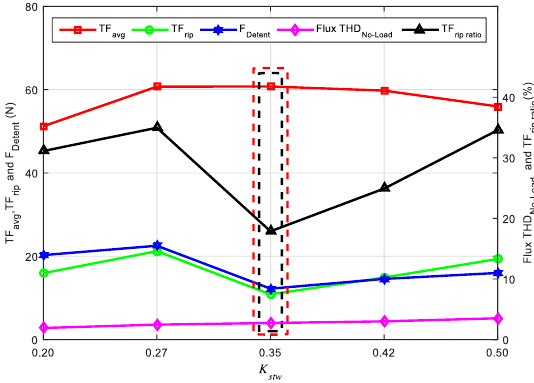
Figure 16. Influence of 𝐾 𝑠𝑡𝑤 on DSLFSPMM-MO4.